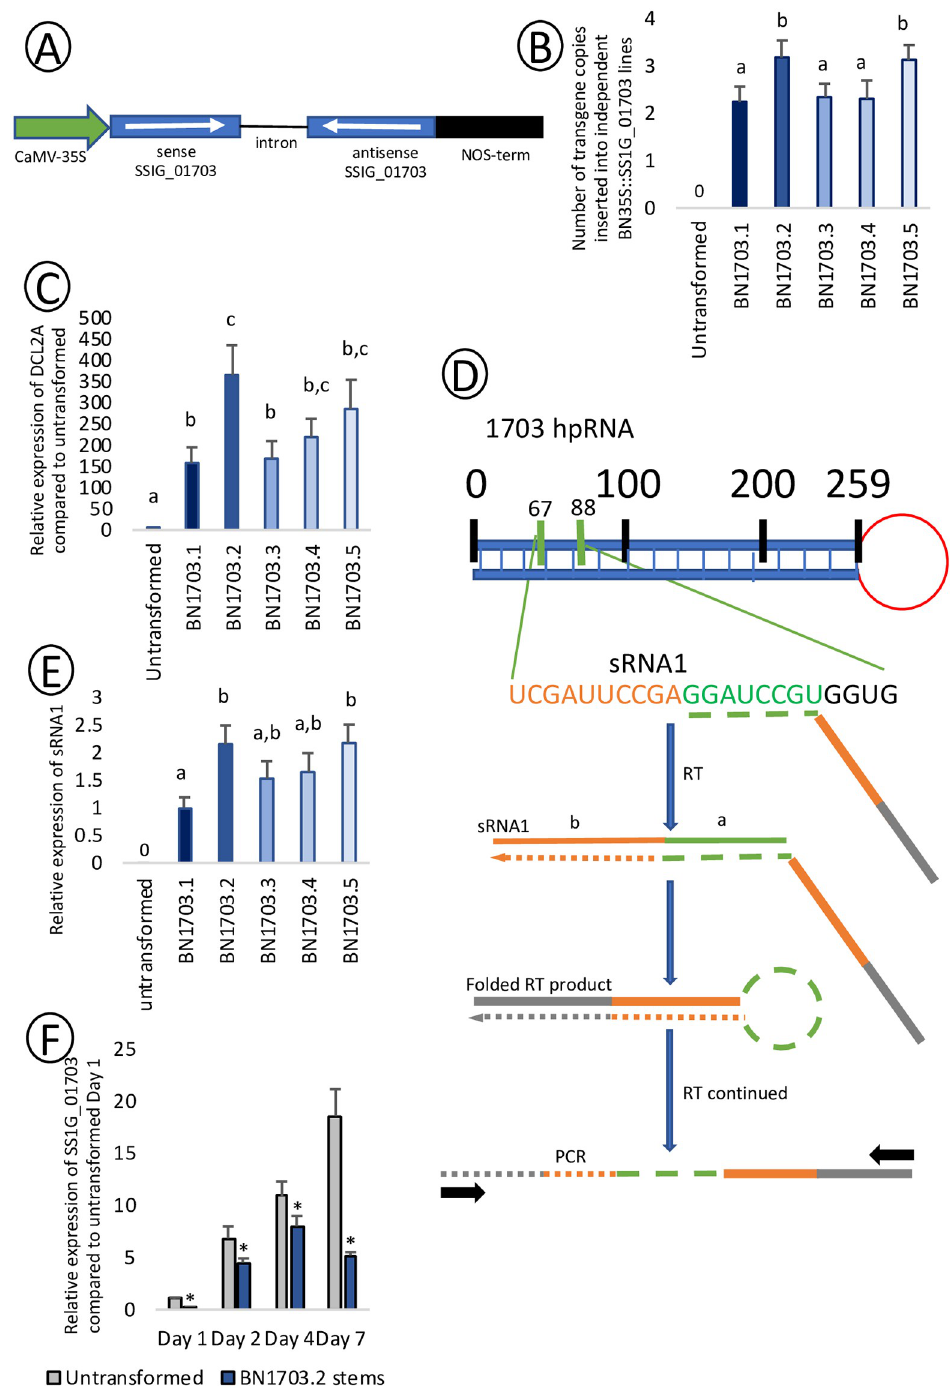
Fig 1. (A) Schematic map of the BN1703 RNAi cassettes within the pHELLSGATE8 vector. The intron-hairpin interfering cassette is under the control of the 35S promotor of Cauliflower mosaic virus. The 259 bp fragment of the ABHYDROLASE-3 gene coding sequence from S . sclerotiorum (SS1G_01703) was directionally cloned to generate sense and antisense arms flanking an intronic spacer. NOS (nopaline synthase) provides selection against kanamycin. (B) Estimated number of BN1703 copies inserted into B . napus transformants. Copy number was determined by comparing relative abundance measured by qPCR to the single copy gene, High Mobility Group protein HMG-I/ HMG-Y. Data for nucleic acid quantifications represents three biological replicates with error bars representing standard error. Statistical differences calculated using ANOVA (with significance of p < 0.05). (C) Relative expression